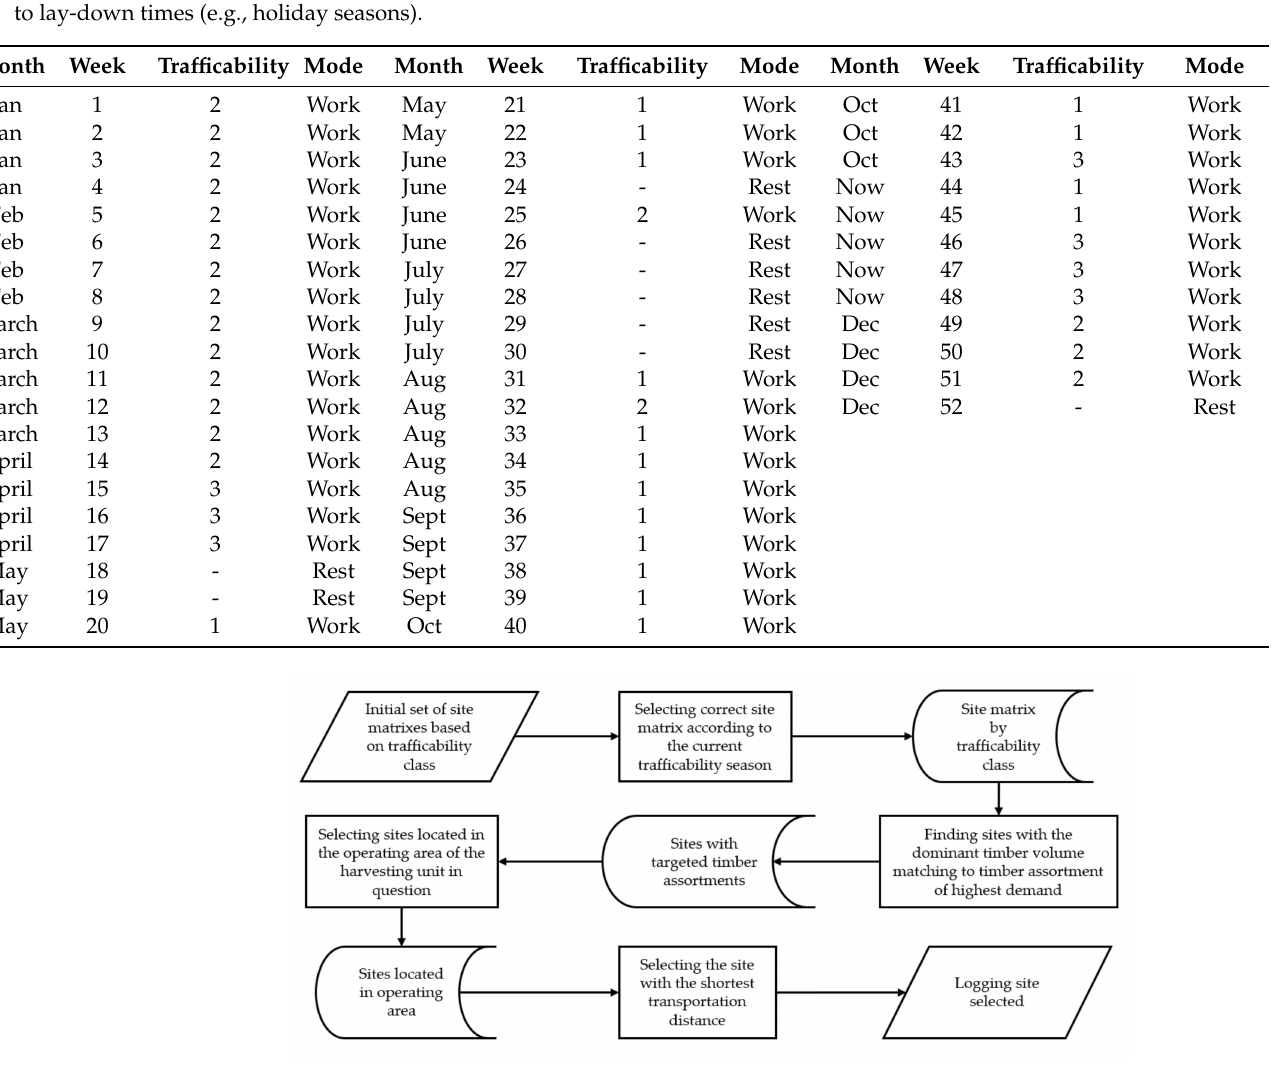
Figure 5. Site selection principle for next site to be